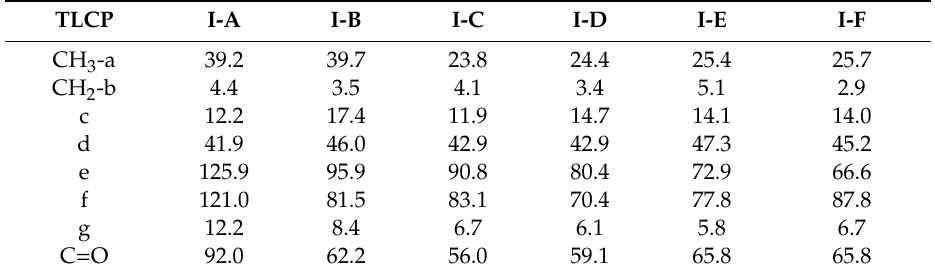
Figure 12. 13 C-NMR chemical shifts of sample II-F at room temperature. In the chemical formula, x:y:z = 1:1:5. The spinning sidebands are marked with asterisks. = 1:1:5. The spinning sidebands are marked with asterisks. x:y:z Table 5. Spin-lattice relaxation time T 1 ρ (ms) in the rotating frame for each carbon in the TLCP-I series at room temperature.